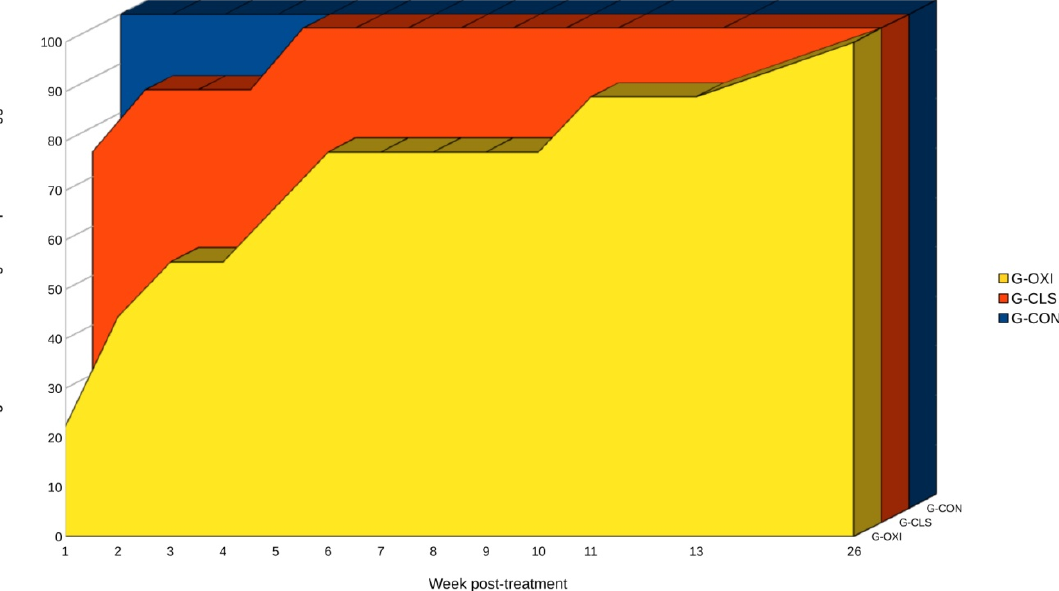
Table 1. Geometric mean egg counts in each group (G-CON, untreated controls; G-CLS, treated with